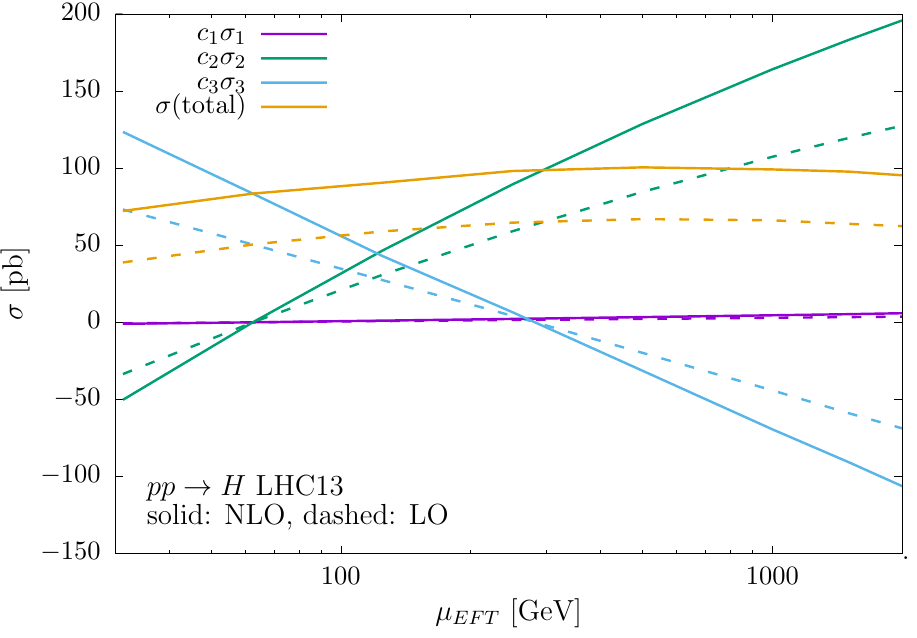
Figure 7 . Contributions of the three operators to the inclusive Higgs production cross section at the LHC at 13 TeV as a function of the EFT scale. Starting from one non-zero coe(cid:14)cient at (cid:22) EFT = m H = 2 we compute the EFT contributions at di(cid:11)erent scales, taking into account the running and mixing of the operators. LO and NLO predictions are shown in dashed and solid lines